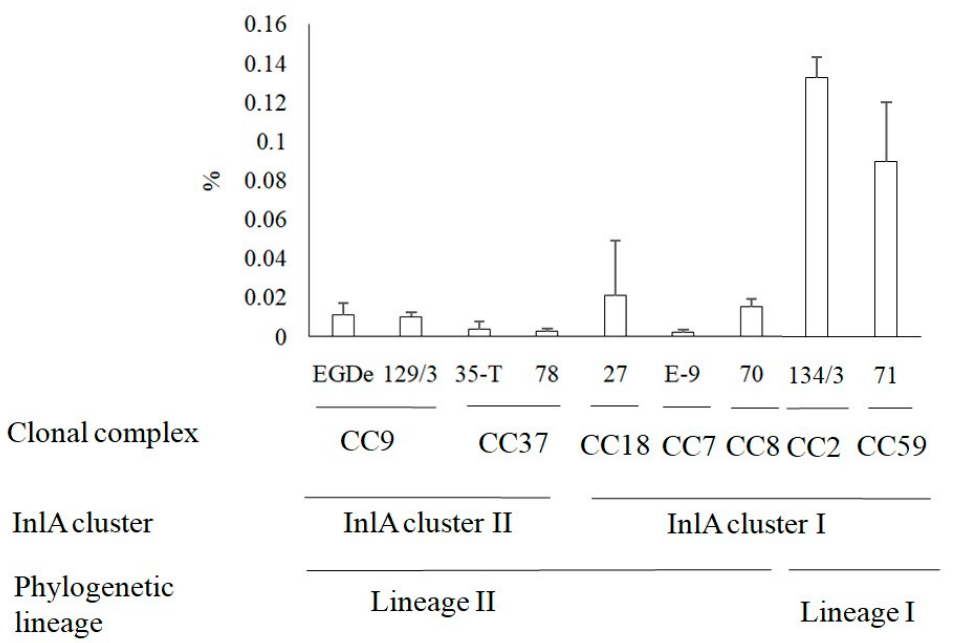
Figure 6. Invasion efficiency of L. monocytogenes into HEp-2 epithelial cells. The invasion coefficient values (ICs) measured as a percentage of invaded bacteria to the number of applied bacteria are shown. Totally, nine strains belonging to seven CCs were tested. ±SD value is based on three independent experiments. Statistical significance is described in the text.